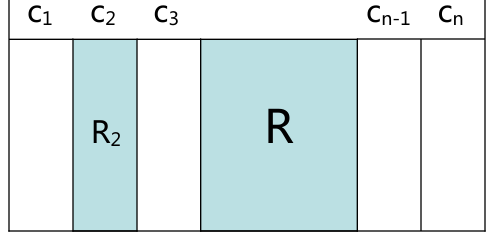
Figure 21 . Special case k L =0 of maximally constructing full cells from full